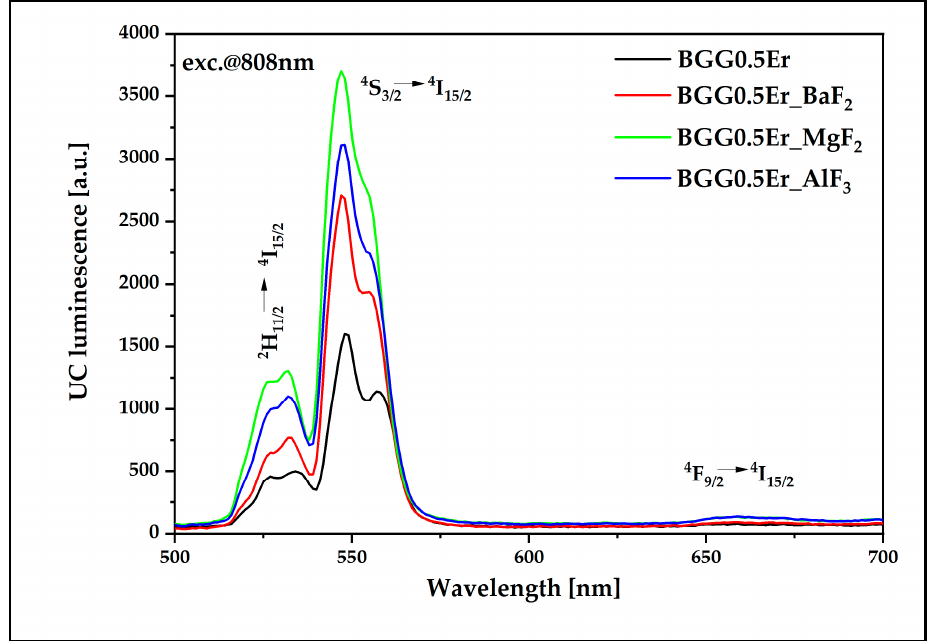
Figure 22. UC luminescence of Er 3+ -doped BGG glass modified by different fluoride compounds under 808 nm laser excitation .